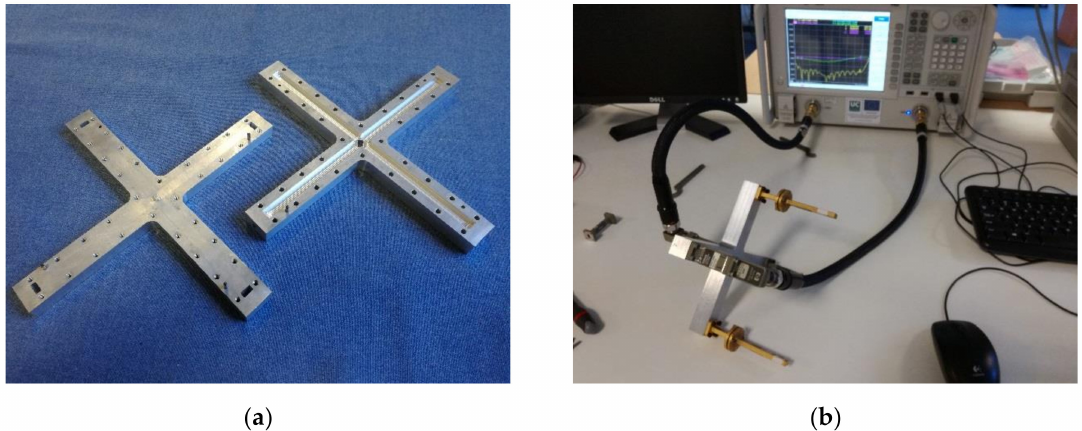
Figure 11. Photographs of the power divider: ( a ) disassembled; ( b ) under